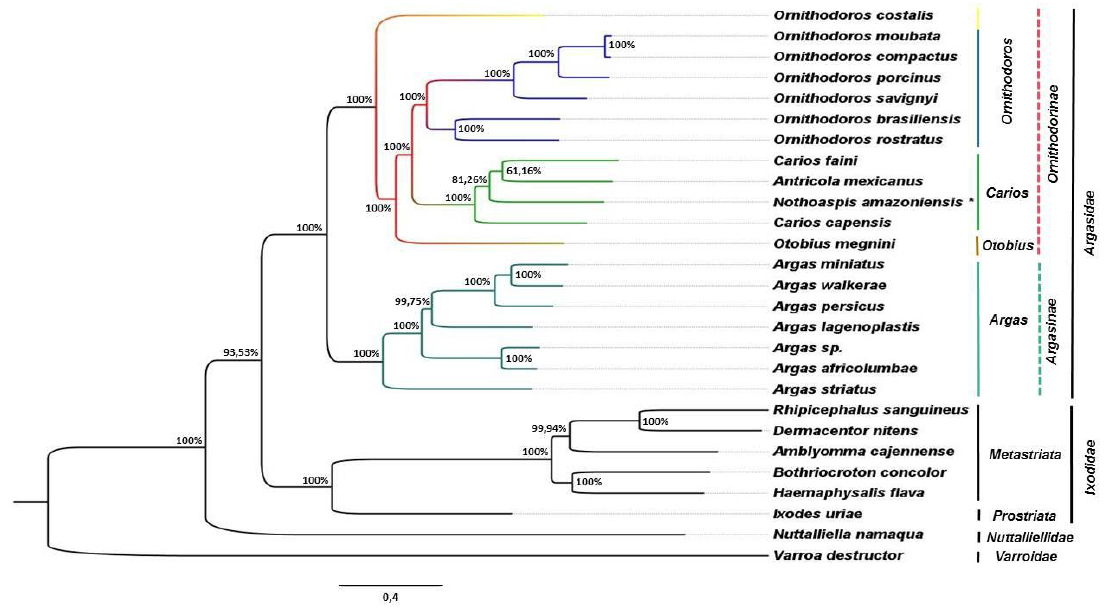
Figure 2. Evolutionary relationships among ticks of the Argasidae, Ixodidae, and Nuttalliellidae families. The major-rule consensus phylogenetic tree was generated by Bayesian Inference analysis of 27 complete sequences of mitochondrial genomes. The posterior probability values (PP) (expressed as percentages), calculated using the best trees found by MrBayes, are shown beside each node. * Species of N. amazoniensis analyzed in this study.